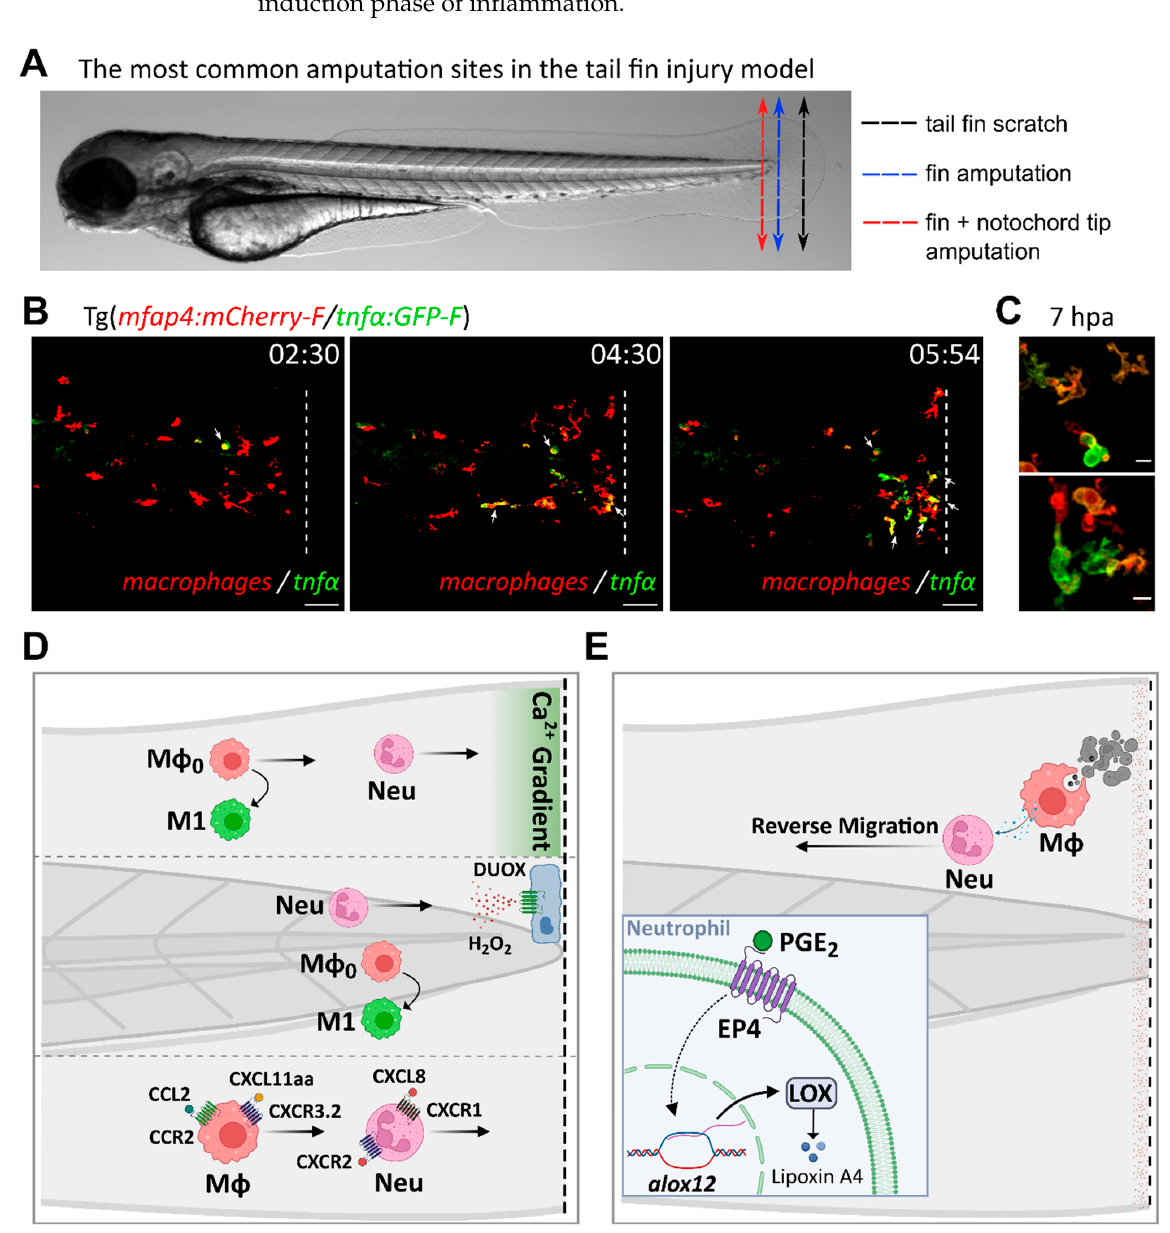
Figure 2. Inflammatory mediators and signaling pathways regulating leukocyte recruitment and activation during sterile injury, as inferred from the tail fin injury model. ( A ). The most common amputation/wounding sites used in the tail fin injury model are highlighted on a representative transmitted light image of a 3 dpf larva. Black dotted arrow: scratch on the tail fin tip. Blue dotted arrow: transection of the fin tip only, just before the notochord. Red dotted arrow: transection of the fin and the tip of the notochord. ( B ). Time-course of macrophage recruitment and activation following tail fin transection (intact notochord). Real-time imaging of the fin fold of a 3 dpf amputated larva